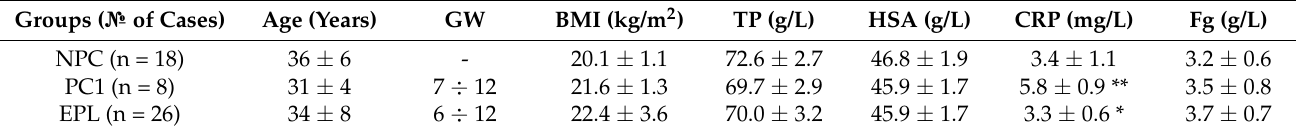
Table 1. Main patients’ characteristics and biochemical parameters (total protein (TP), human serum albumin (HSA), C-reactive protein (CRP), fibrinogen (Fg) level), determined for non-pregnant (NPC) and pregnant women in the first trimester of pregnancy (PC1), and patients with early pregnancy loss (EPL). Mean values ±